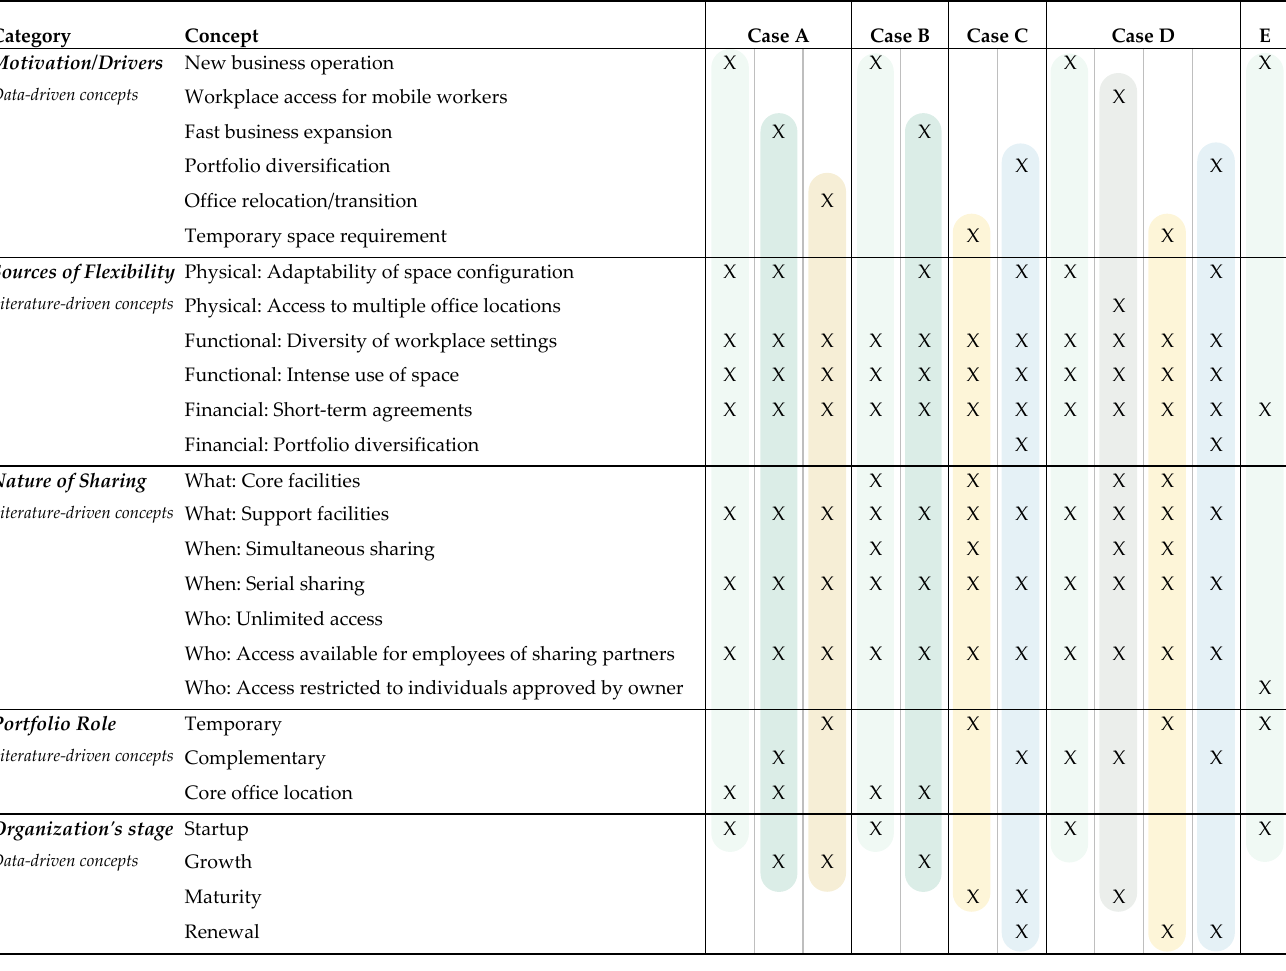
Table 2. Summary of motivations and approaches to implementing co-working in each case study.